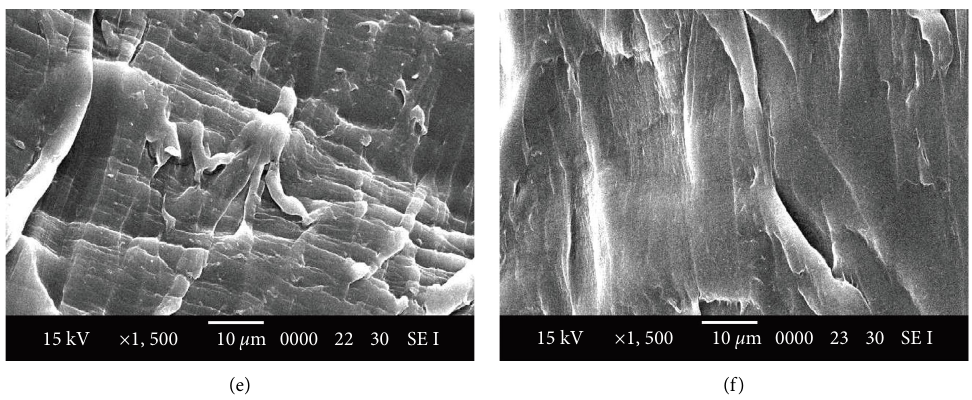
Figure 7: SEM images of (a) pure PP, (b) 1wt%, (c) 2wt%, (d) 3wt%, (e) 4wt%, and (f) 5 wt% #16